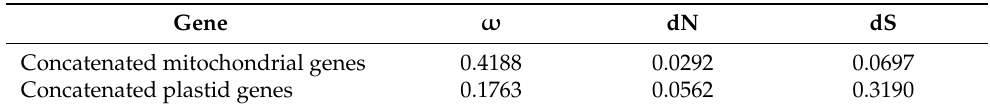
Table 2. Substitution rates of overall mitochondrial genes and plastid genes between S. plumbizincicola and H. parviflora